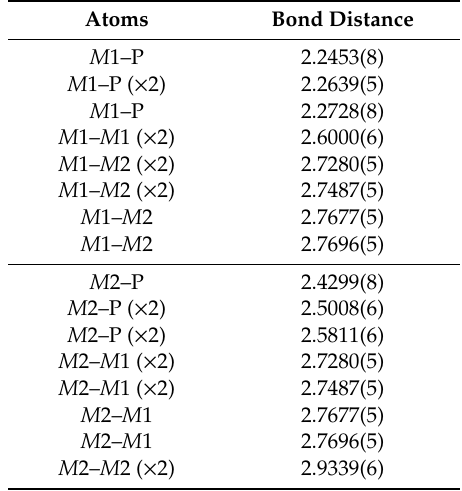
Table 4. Selected bond distances (Å) for grammatikopoulosite.